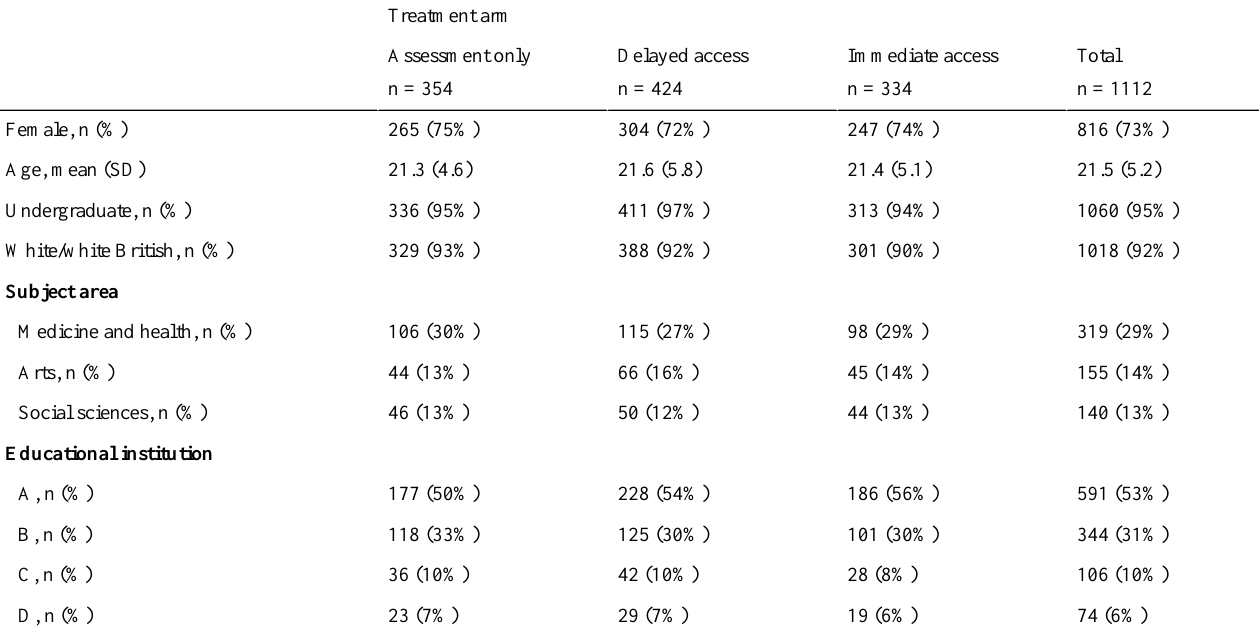
Table 1. Demographics of participants at baseline by treatment arm allocation